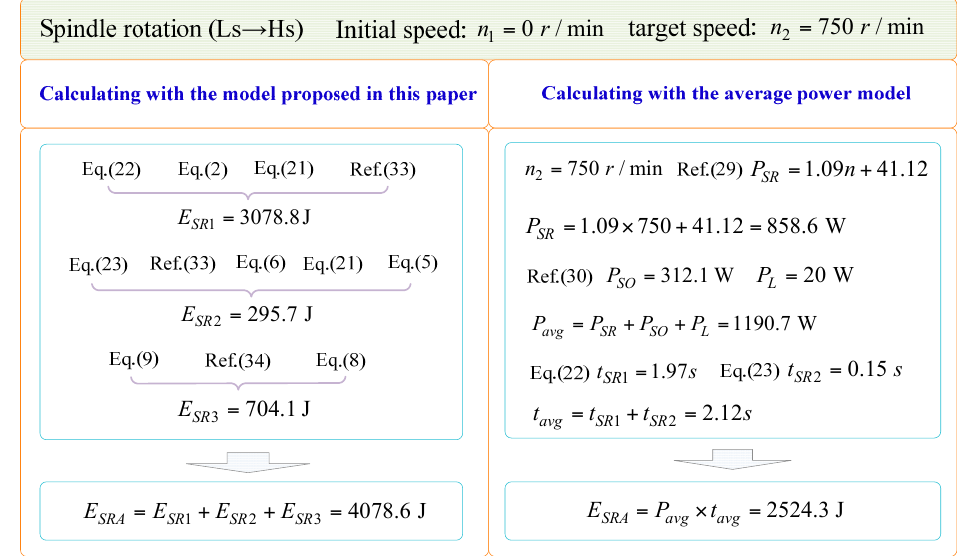
Figure 15. Energy demand calculated with the model proposed in this paper and the average power model.